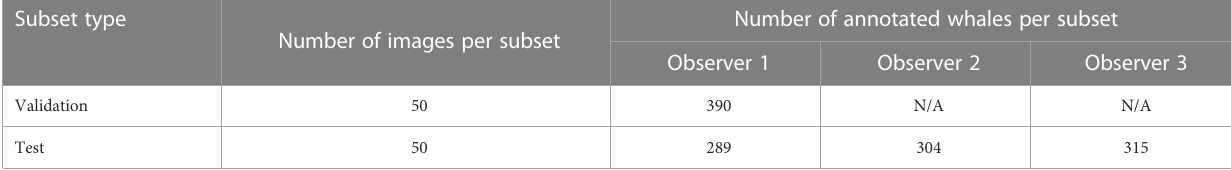
TABLE 1 Summary of annotations for the validation and test subsets according to the three observers. Subset